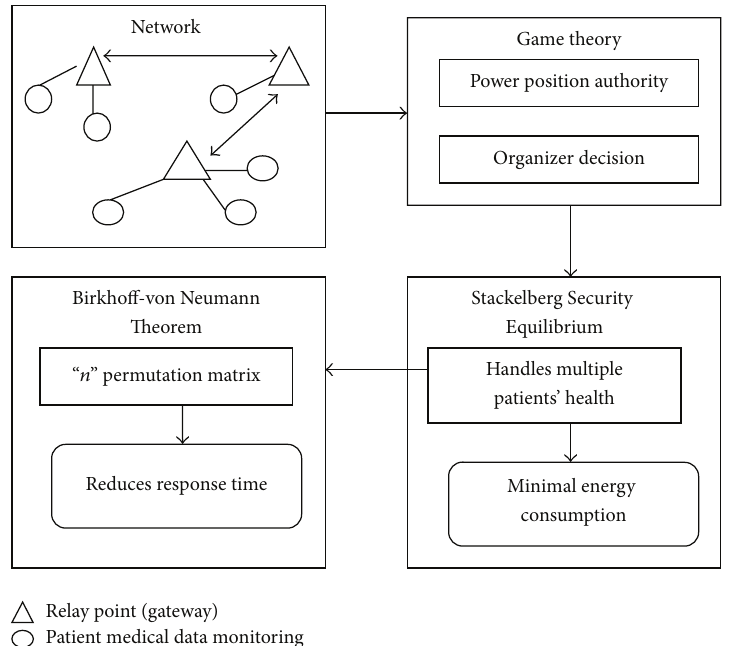
Figure 2: Steps on monitoring patients information in